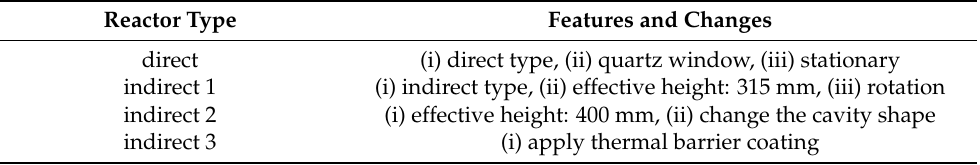
Table 2. Reactor development